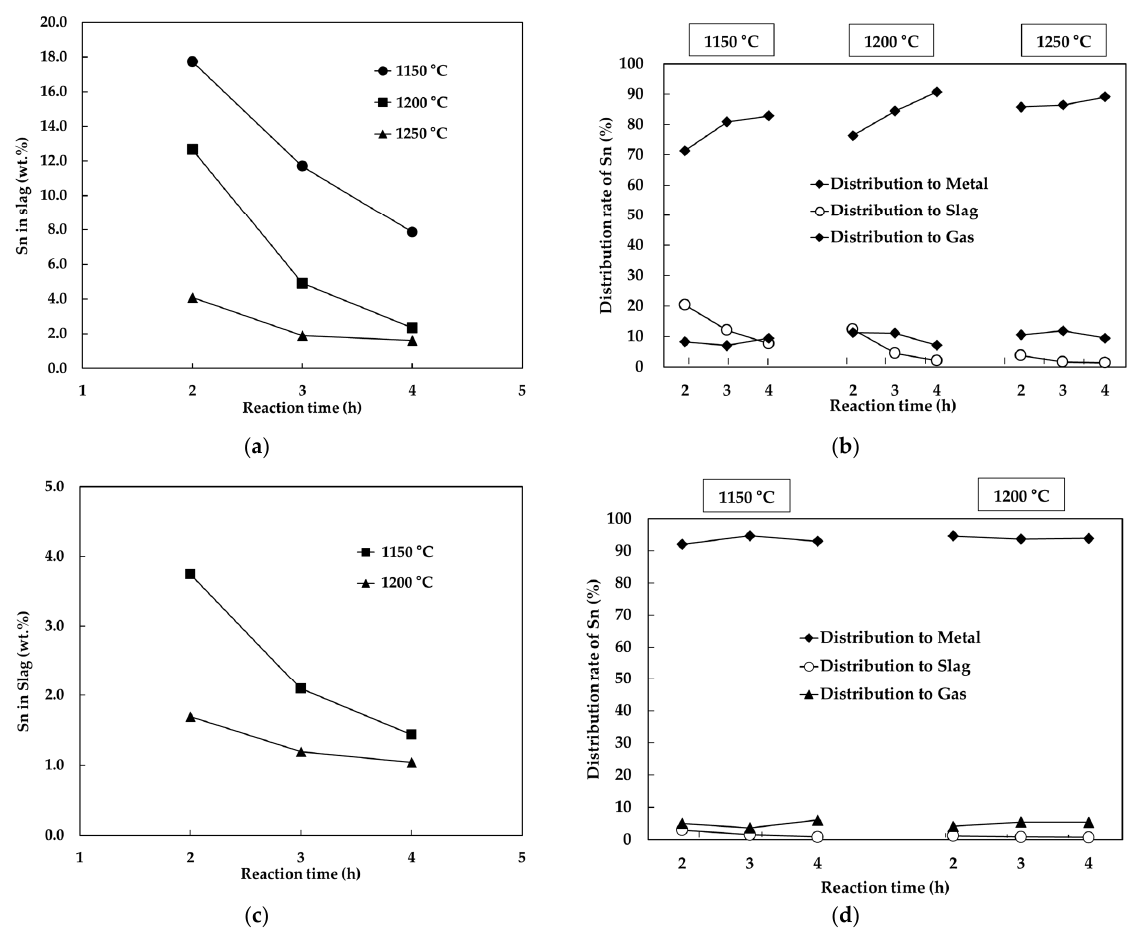
Figure 9. The effect of time ( a ) on the tin content in slag (Na 2 O/SiO 2 = 0.40); ( b ) on the distribution of tin (Na 2 O/SiO 2 = 0.40); ( c ) on the tin content in slag (Na 2 O/SiO 2 = 0.55); ( d ) on the distribution of tin (Na 2 O/SiO 2 = 0.55).